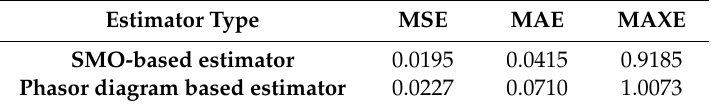
Table 7. Performance indices of the SMO-based estimator and the phasor diagram based